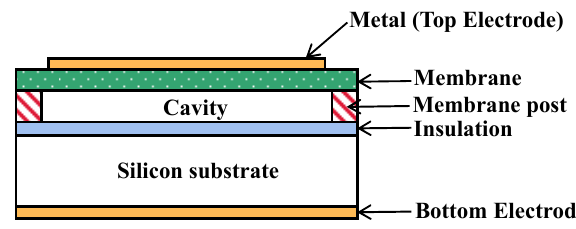
Figure 3. Schematic cross-section of CMUT cells.